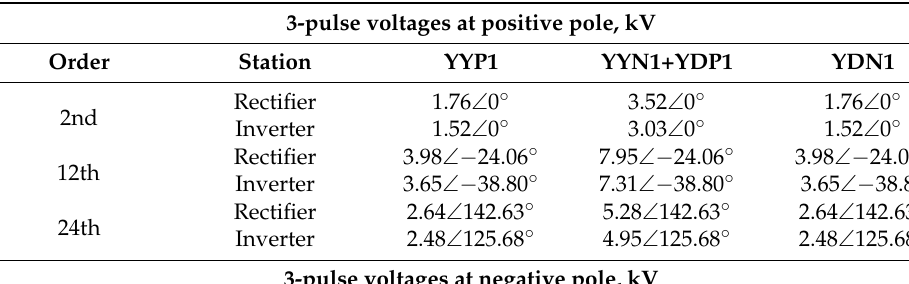
Table 2. Three-pulse voltages of bipolar and full DC voltage